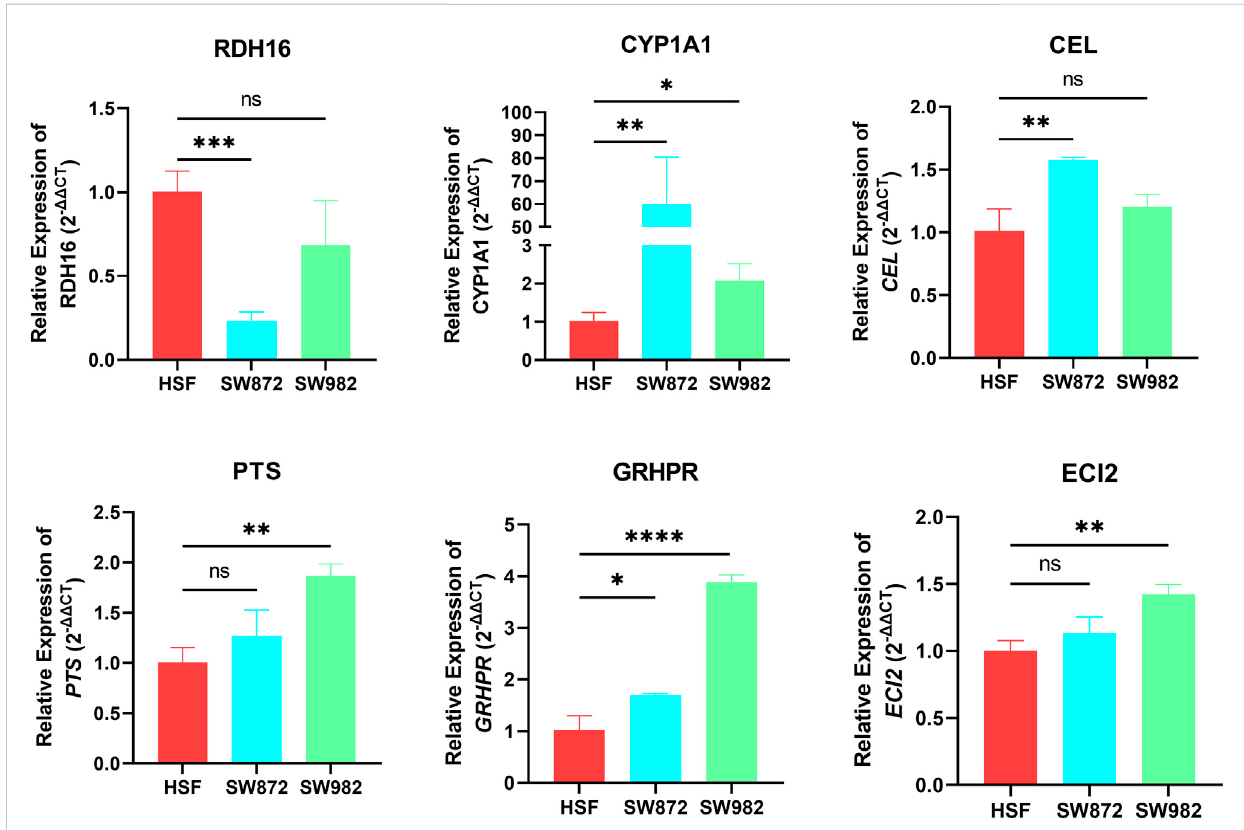
FIGURE 9 The mRNA expression of RDH16, CYP1A1, CEL, PTS, GRHPR, and ECI2 was examined by RT ‒ qPCR in HSF and STS cell